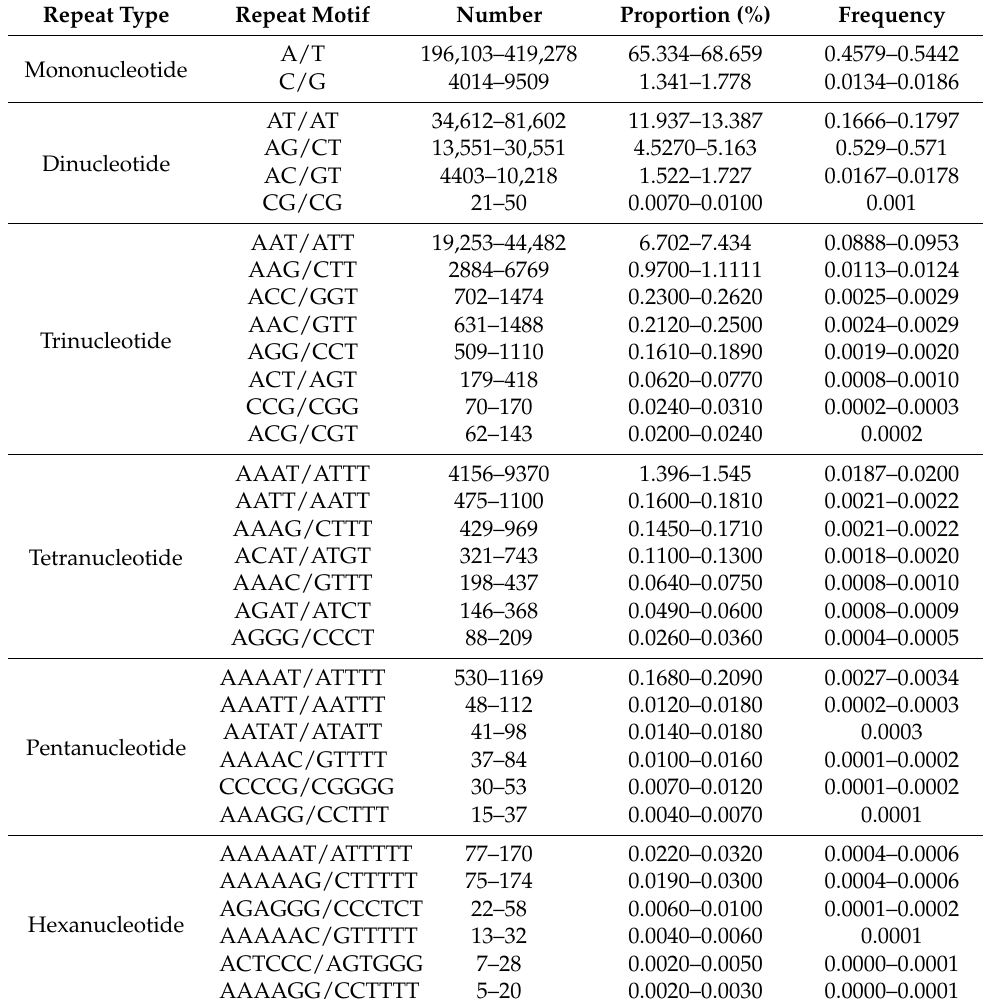
Table 2. Analysis of repeat motif types in grape